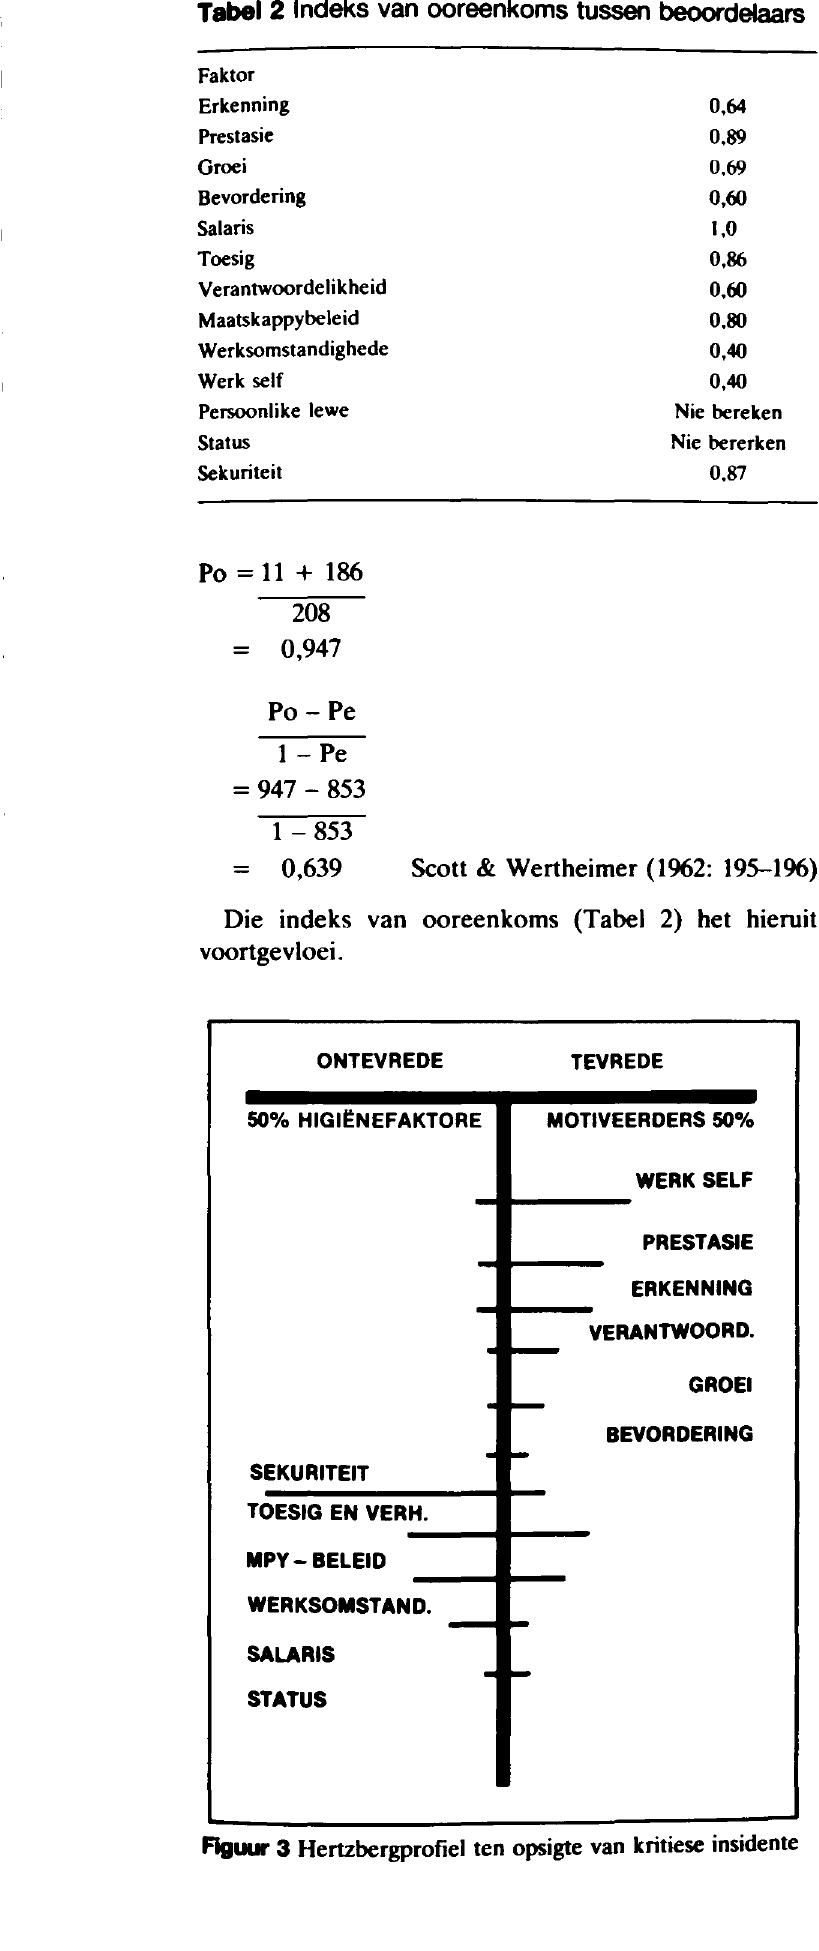
Figuur 3 Hertzbergprofiel ten opsigte van kritiese